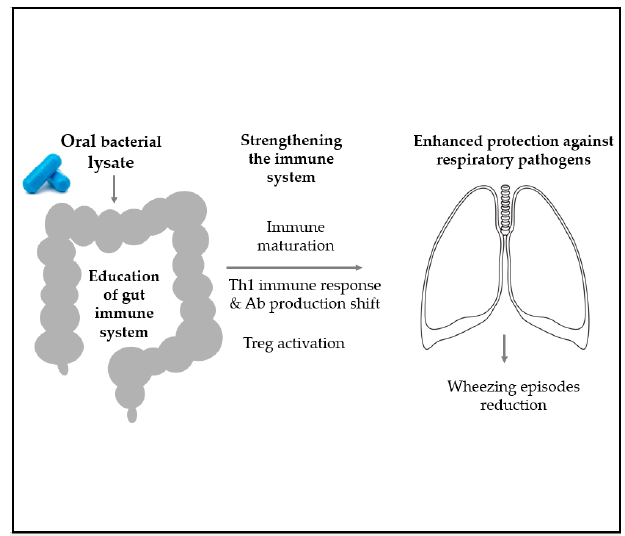
Figure 8. Oral lyophilized bacterial lysates (OBLs) could educate the gut immune system and contribute to the reduction of inflammation. In parallel, these compounds were shown to activate some pathways in the gut and provide the host with a broad protection against respiratory pathogens, via the migration of immune sensors and effectors from the GALT in the PPs to the MALT.